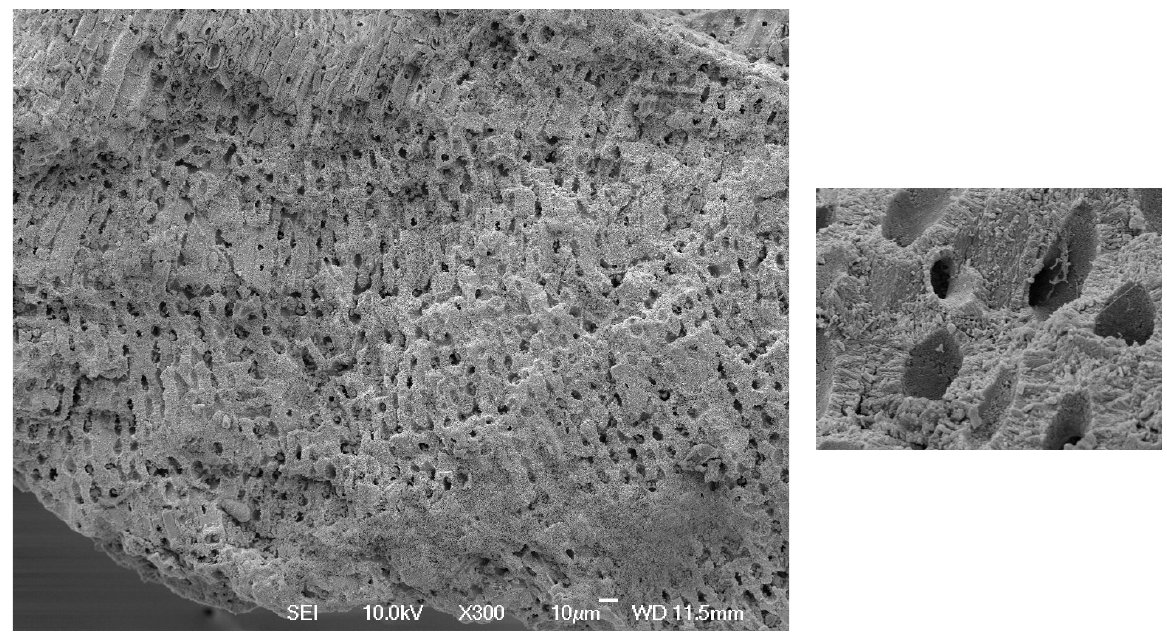
Figure 1. Scanning electron microscopic images of the mineralized cellular structure of Lithothamnion after being extracted and milled. As shown, the original microstructure of the harvested fragments used for making LithoLexal ® is preserved. Images are courtesy of Marigot Ltd. (West Sussex, UK).